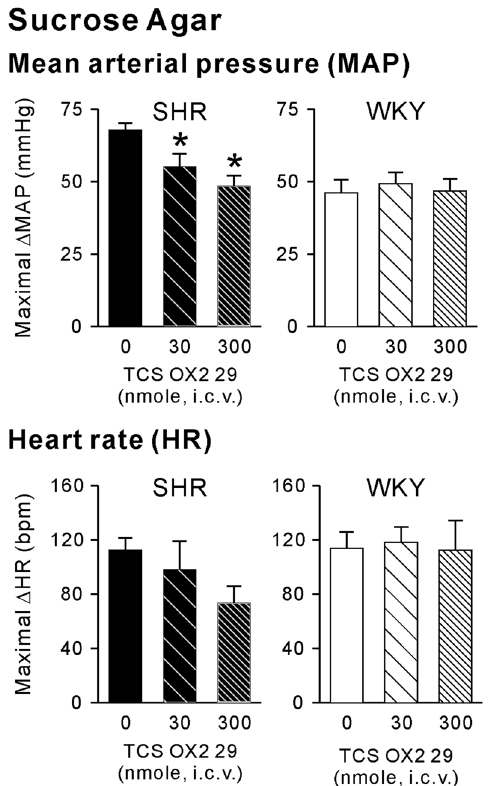
Figure 3. Effects of the orexin 2 receptor (OX2R) antagonist, TCS-OX2-29, on palatable-food consumption- associated cardiovascular responses in spontaneously hypertensive rats (SHR) and Wistar Kyoto rats (WKY). Bar graphs show maximal changes in the mean arterial pressure (maximal Δ MAP) (upper panel) and heart rate (maximal Δ HR) (lower panel) in response to consumption of sucrose agar in SHR and WKY that received intracerebroventricular (i.c.v.) vehicle (n = 6), 30 nmol TCS-OX2-29 ( n = 6), or 300 nmol TCS-OX2-29 ( n = 6). Data are expressed as the mean ± SEM. A star “ * ” indicates a significant difference between the indicated group and vehicle group, as determined by a one-factor ANOVA followed by Duncan’s multiple-range